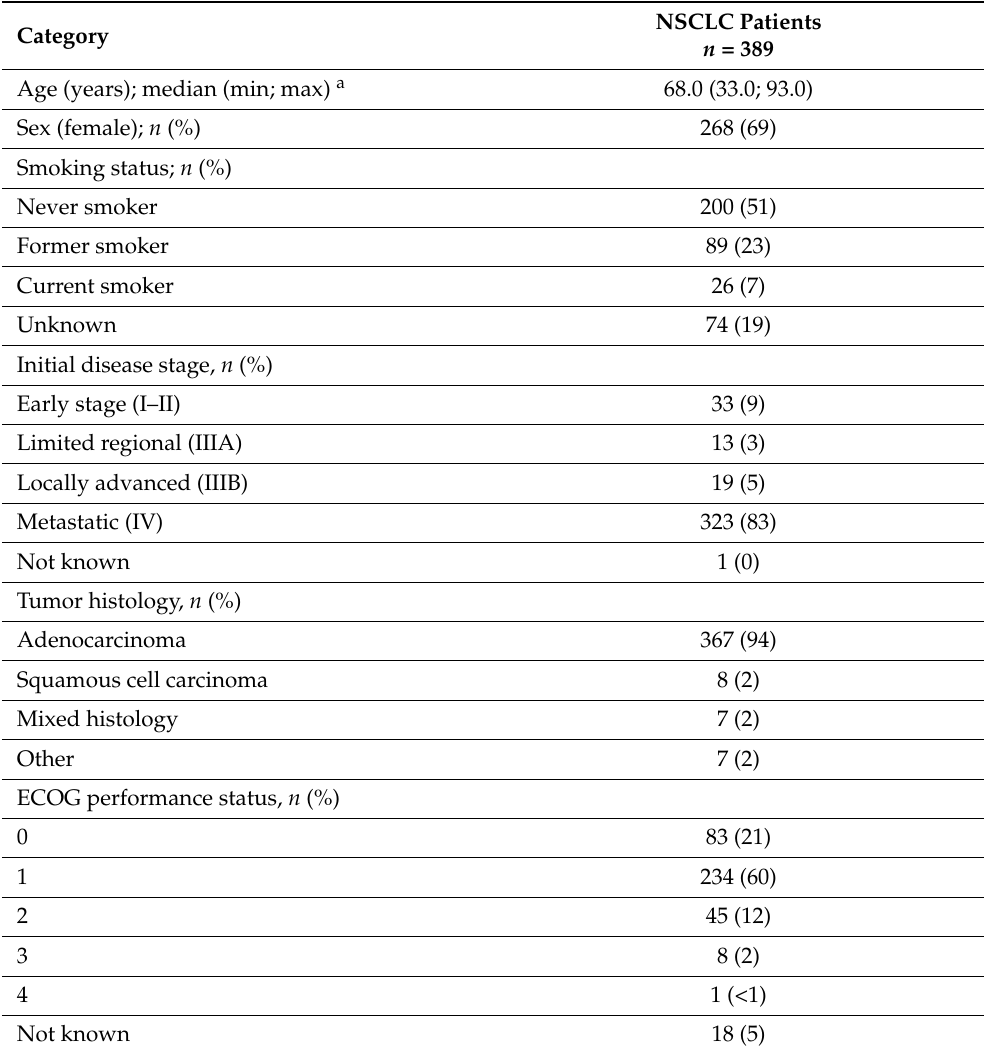
Table 1. Patient demographics at baseline and disease characteristics at initial advanced/metastatic NSCLC diagnosis (CEE